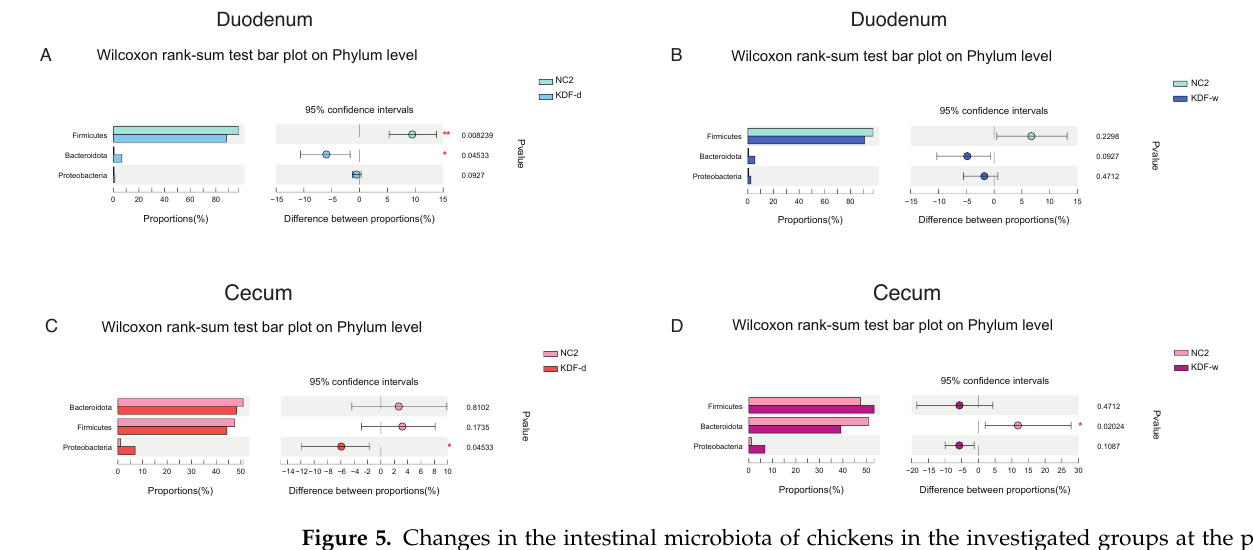
Figure 5. Changes in the intestinal microbiota of chickens in the investigated groups at the phy- lum level. ( A ) Duodenum contents in the NC2 group compared with those in the KDF-d group. ( B ) Duodenum contents in the NC2 group compared with those in the KDF-w group. ( C ) Cecum contents in the NC2 group compared with those in the KDF-d group. ( D ) Cecum contents in the NC2 group compared with those in the KDF-w group. NC2: chickens supplied with non-supplemented diet and water without infection (n = 6); KDF-d: chickens supplied with 0.5% KDF in diet without infection (n = 6); KDF-w: chickens supplied with 0.1% KDF in drinking water without infection (n = 6). * p < 0.05, ** p < 0.01.